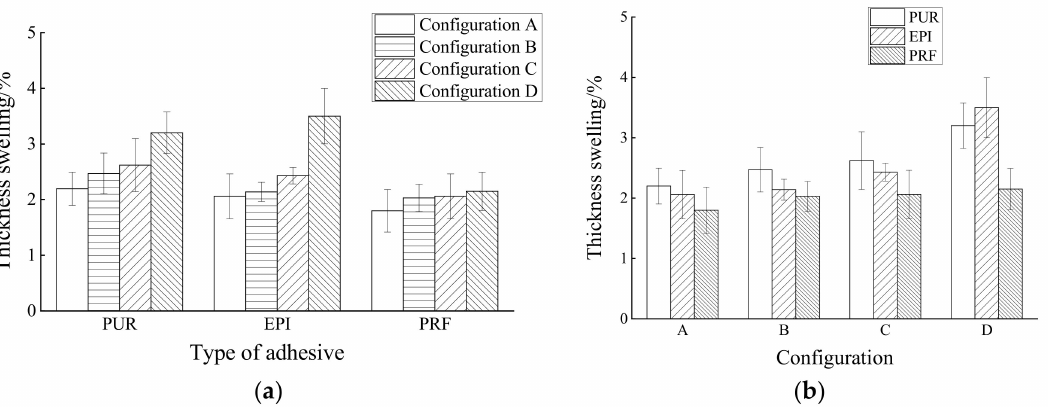
Figure 3. TS of CLT and HCLT specimens: ( a ) Influence of configuration, and ( b ) Influence of adhesive.